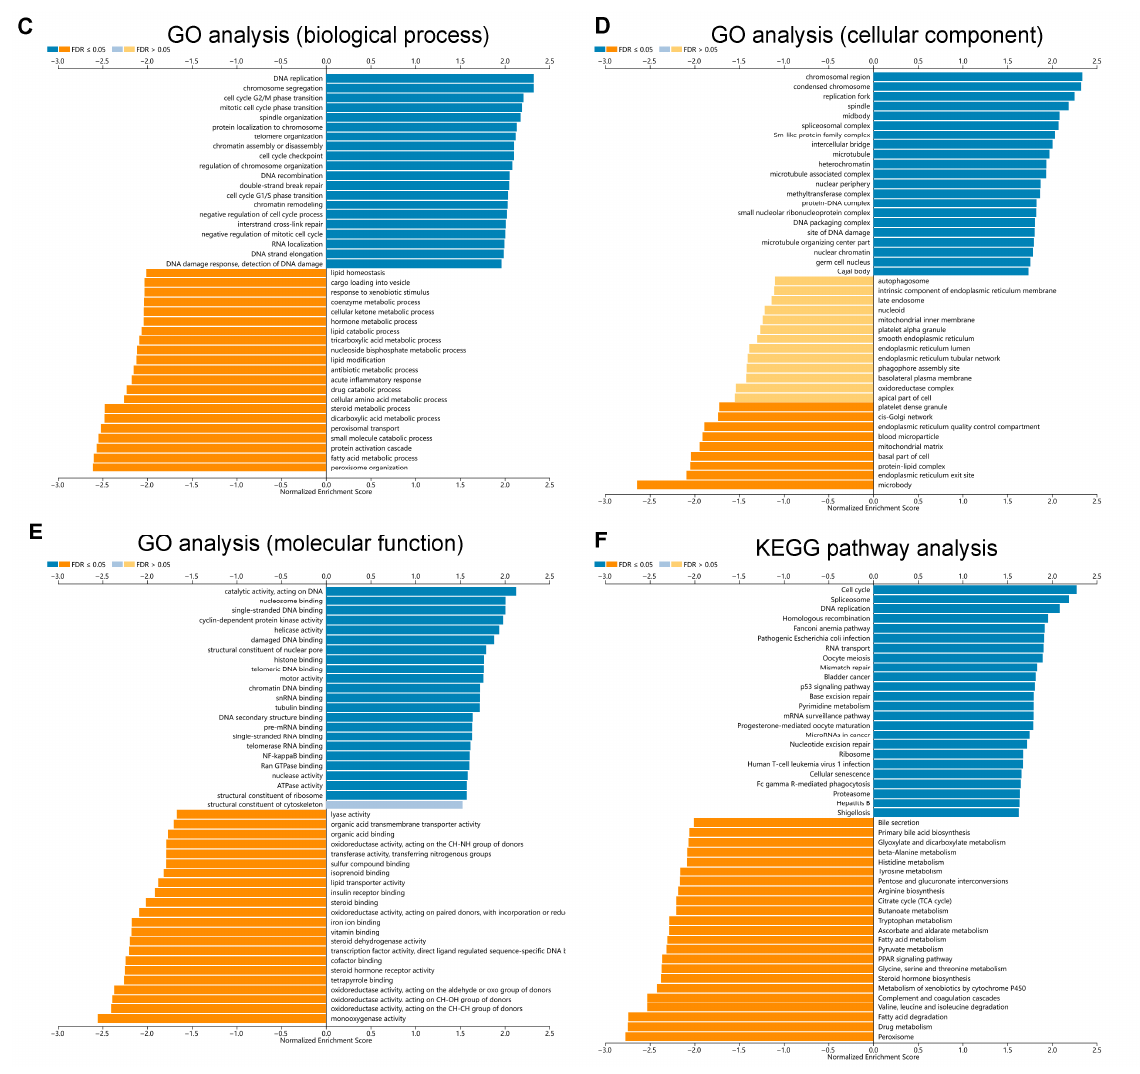
Figure 7. Construction of PPI networks for TUBA1B and analysis of GO function annotation and KEGG pathway enrichment of TUBA1B. ( A ) PPI network of TUBA1B constructed from GeneMANIA. ( B ) PPI network of TUBA1B constructed from STRING. ( C ) GO analysis of the biological process of TUBA1B. ( D ) GO analysis of cellular component of TUBA1B. ( E ) GO analysis of molecular function of TUBA1B. ( F ) KEGG pathway analysis of